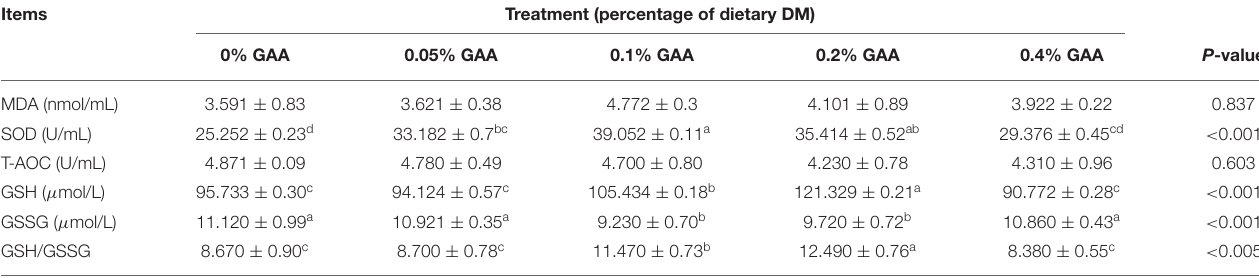
TABLE 5 | Effects of dietary GAA on antioxidant indexes of Jinjiang bull